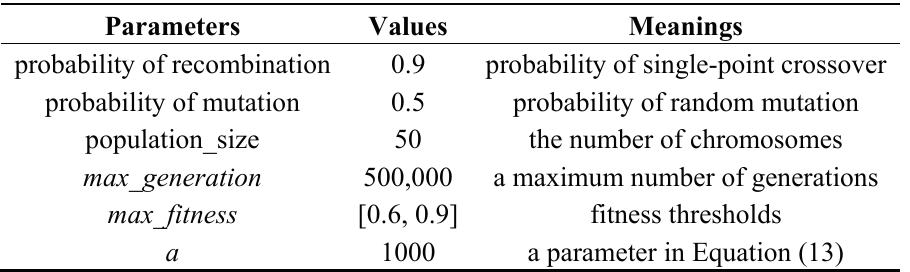
Table 1. The parameters in the integrated